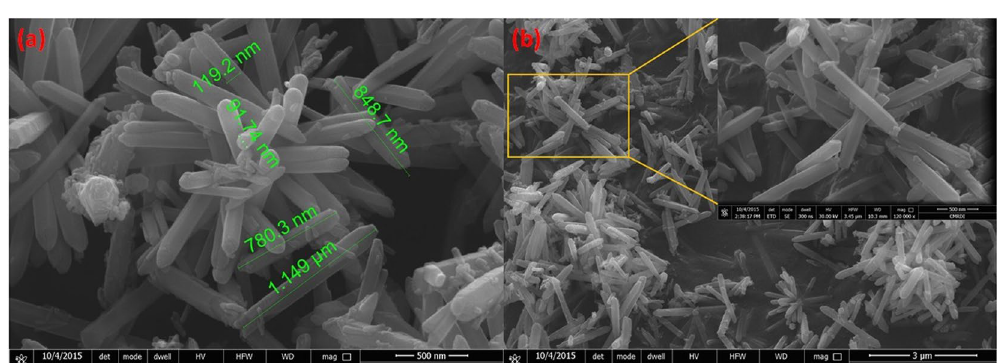
Figure 5. FESEM images of hexagonal ZnO nanorods ( a , b